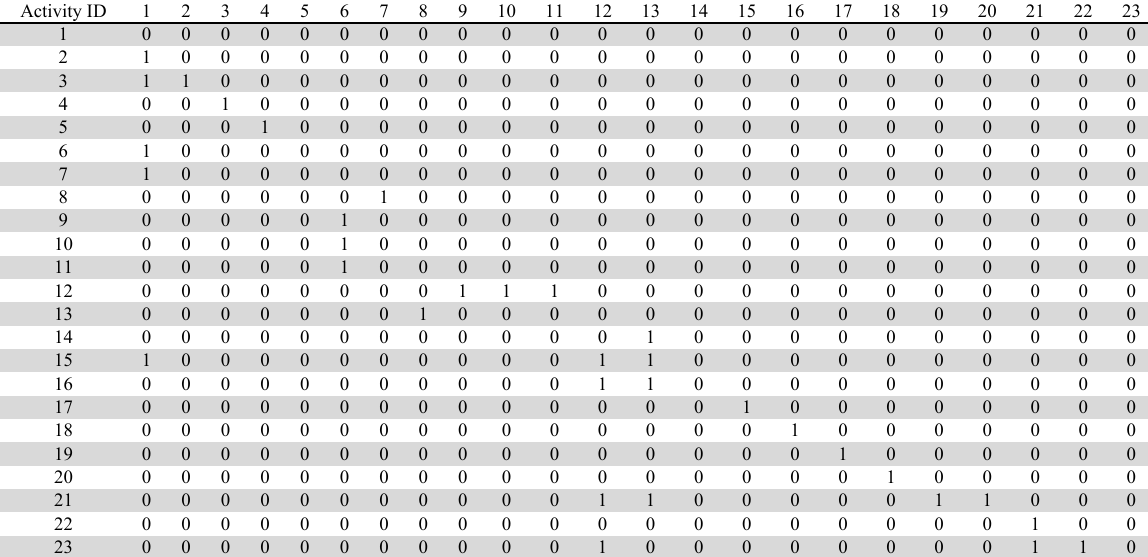
Precedence matrix for the experiment